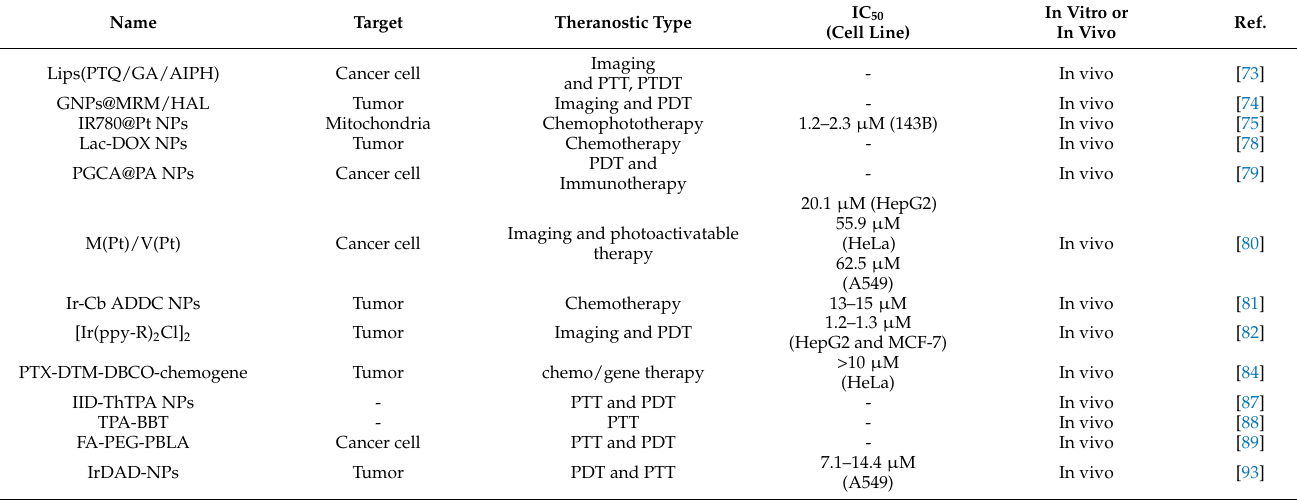
Table 2. Amphiphile molecule-based assembly for theranostic